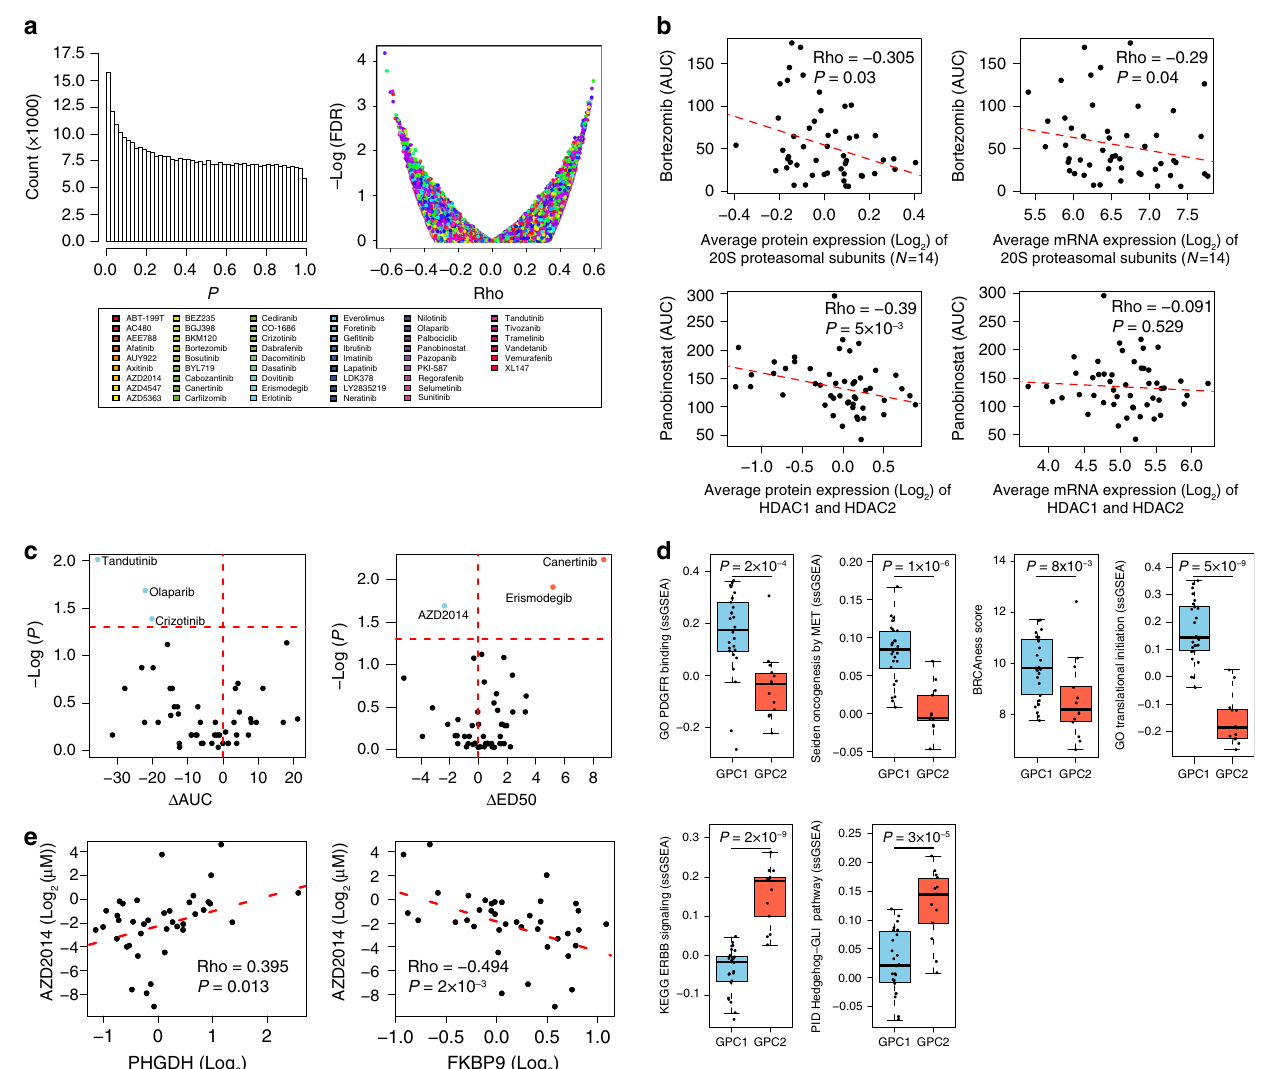
Fig. 6 Subtype-speci fi c and biomarker-dependent sensitivities to targeted therapies. a Correlation tests between the drug – response (AUC and ED50) and the abundance of global proteins. (Left) Histogram of P -values, and (right) FDR score distribution. Rho and P- values were obtained by Spearman ’ s correlation test. b Correlations between expression levels of the indicated proteins (or mRNAs) and responses to the indicated pharmacological compounds targeting them. Rho and P -values were obtained by Spearman ’ s correlation test. c GPC1 or GPC2-selective cytotoxicity pro fi le of the indicated targeted therapies to patient-derived tumor cells matched to the proteomic cohort. The x axes represent differences in mean AUC (left panel) and mean ED50 (right panel) values between GPC1 and GPC2 PDCs. Statistically signi fi cant GPC1 and GPC2-selective drugs were identi fi ed by two-sided Kolmogorov – Smirnov test ( P- values < 0.05; horizontal dashed line) (blue: GPC1 sensitivity, red: GPC2 sensitivity). d Subtype-speci fi c differences in relevant gene sets to GPC1-selective (upper panels) and GPC2-selective (lower panels) drugs in c . P- values were obtained with two-sided unpaired Wilcoxon rank-sum test. The number of samples for GPC1 and GPC2 is 26 and 13, respectively. The box-and-whisker plots represent the medians (middle line), fi rst quartiles (lower bound line), third quartiles (upper bound line) and the ±1.5× interquartile ranges (whisker lines); the raw data are overlaid. See “ Methods ” for details. PDGFR platelet-derived growth factor receptor. e Correlation between the expression levels of the indicated proteins and the response to the indicated pharmacological compound. Rho and P- value were obtained by Spearman ’ s correlation test. Source data are provided as a Source Data fi